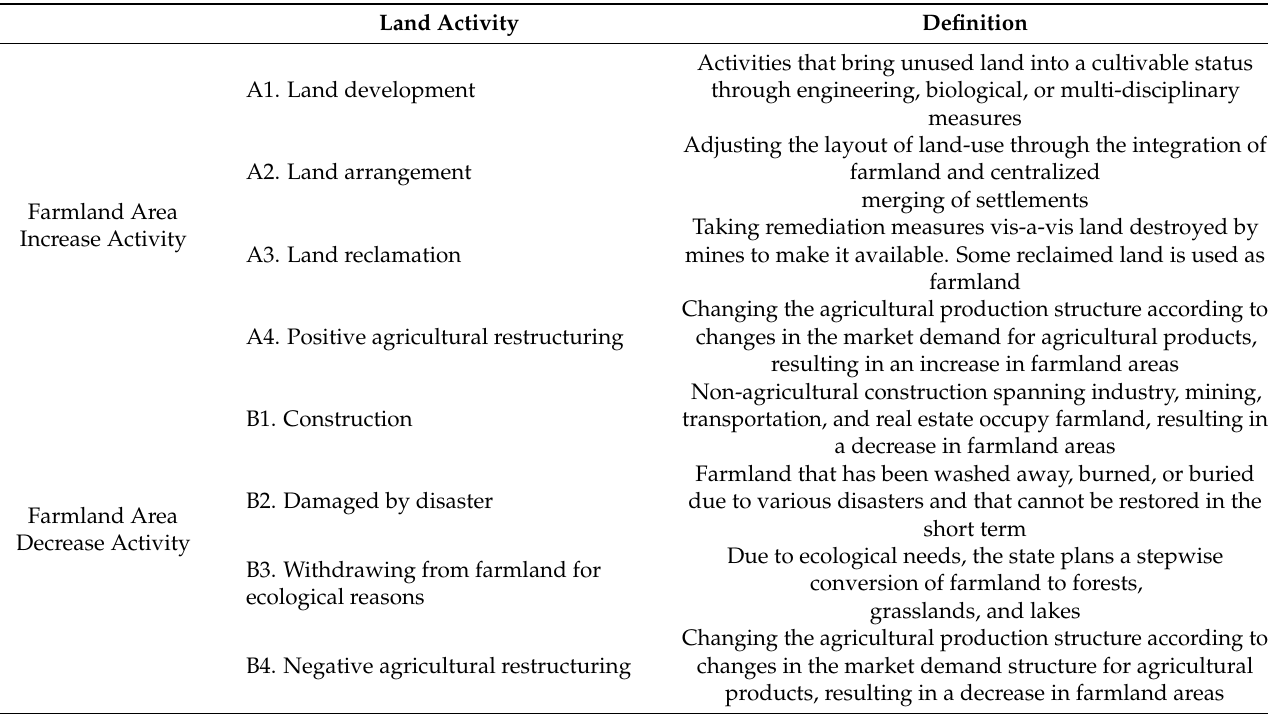
Table 1. Land activity